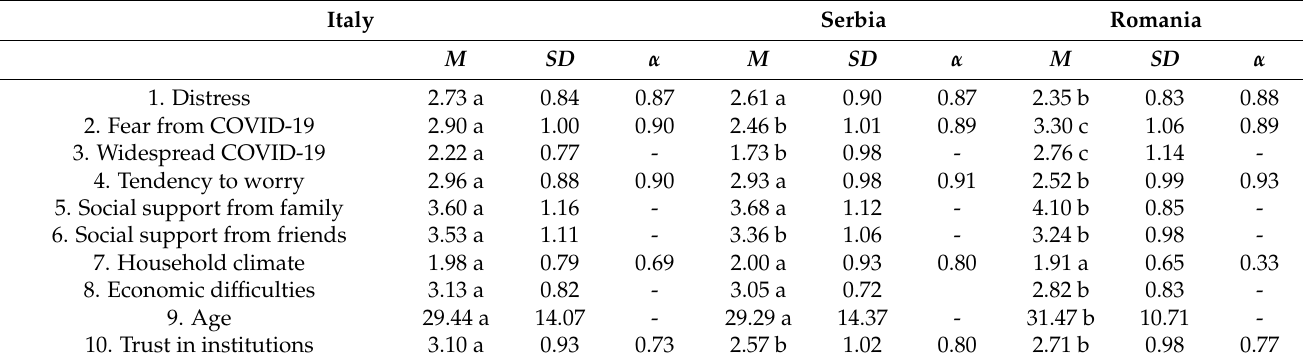
Table 2. Summary statistics of variables (Italy n = 491; Serbia n = 297; Romania n = 312). Italy Serbia Romania M SD α M